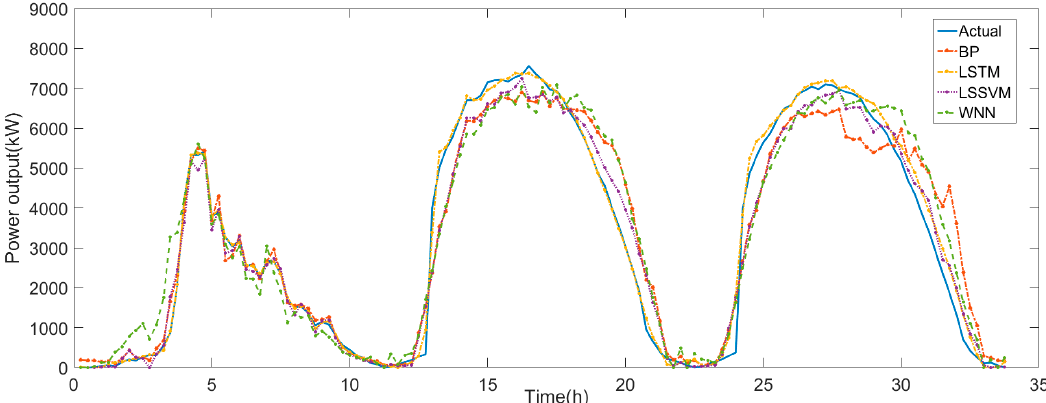
Figure 13. Short-term PV power forecasting in winter by various algorithms.